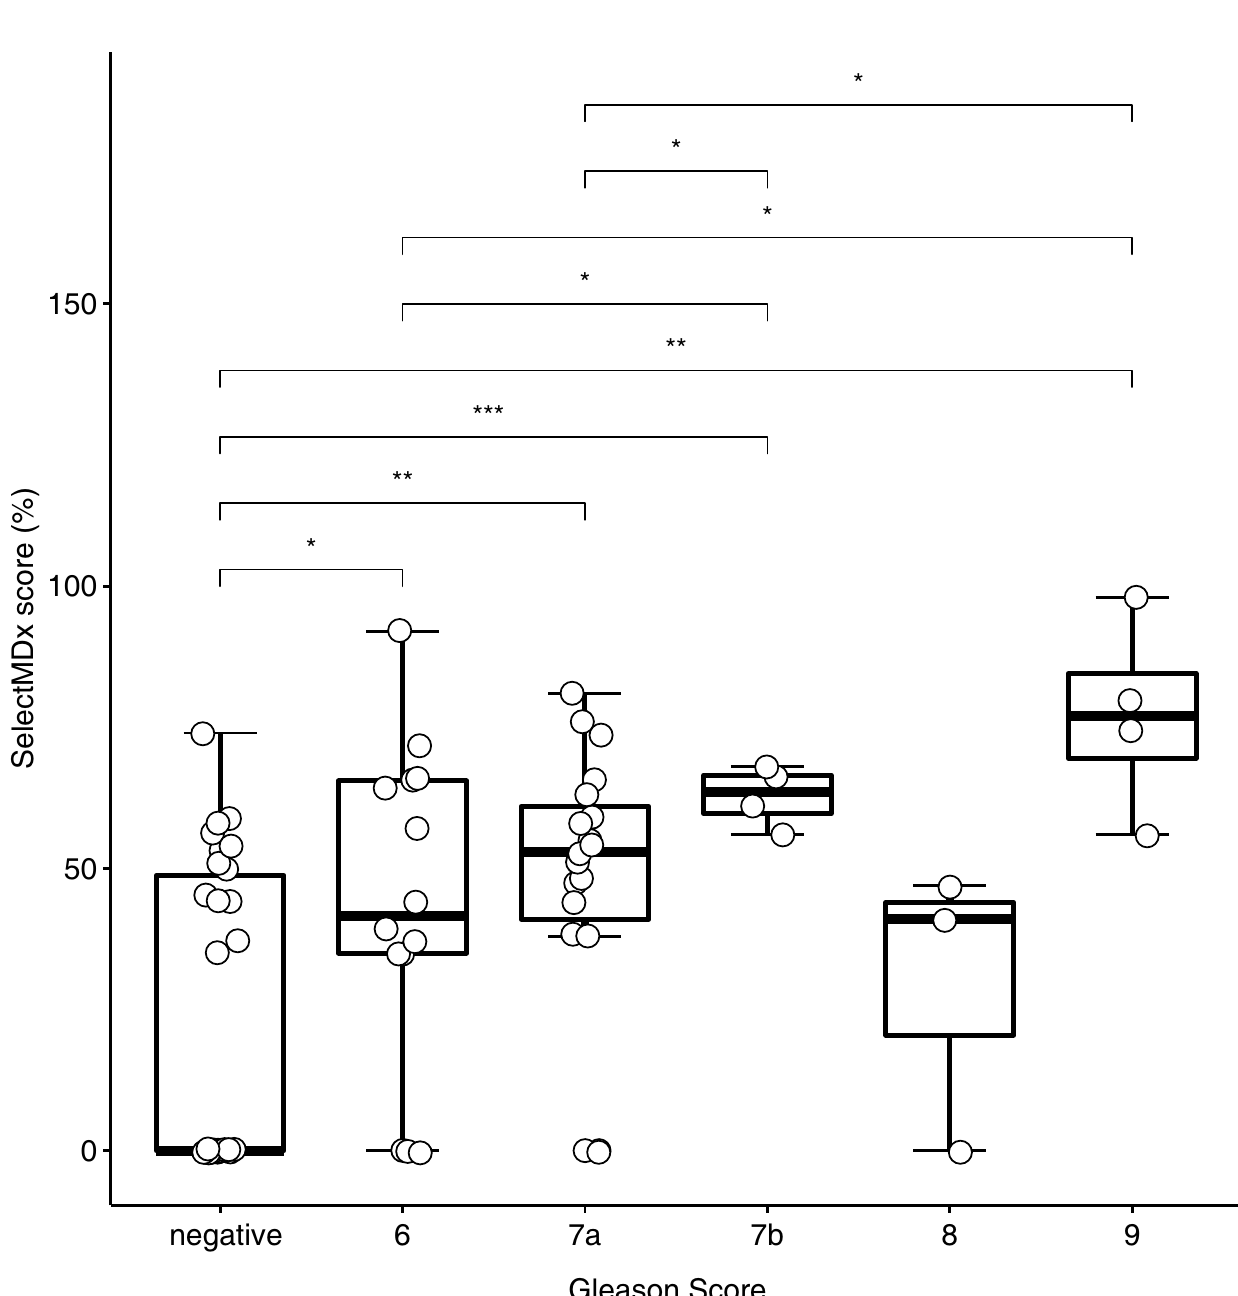
Fig 2. Box plot depicting SelectMDx 1 scores for different Gleason scores. Each paired boxplot with a statistically significance in means, was indicated using asterisks with the following, standardized significance codes: � p < 0.05, �� p < 0.01, ��� p < 0.001. Of note, when dichotomizing into cohorts with patients � GS 7a and > 7a, a higher GS was associated with a significantly higher SelectMDx 1 score (58.82 ± 25.08% vs. 34.48 ± 28.55%; p = 0.01).